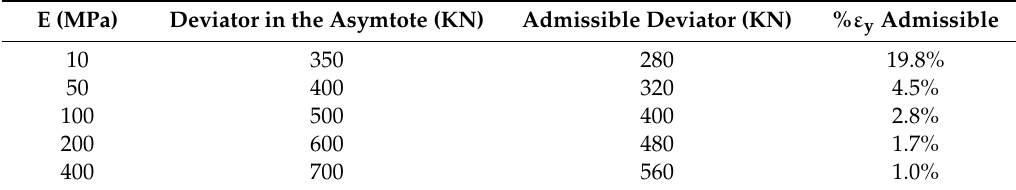
Table A2. Admissible deformation definition.